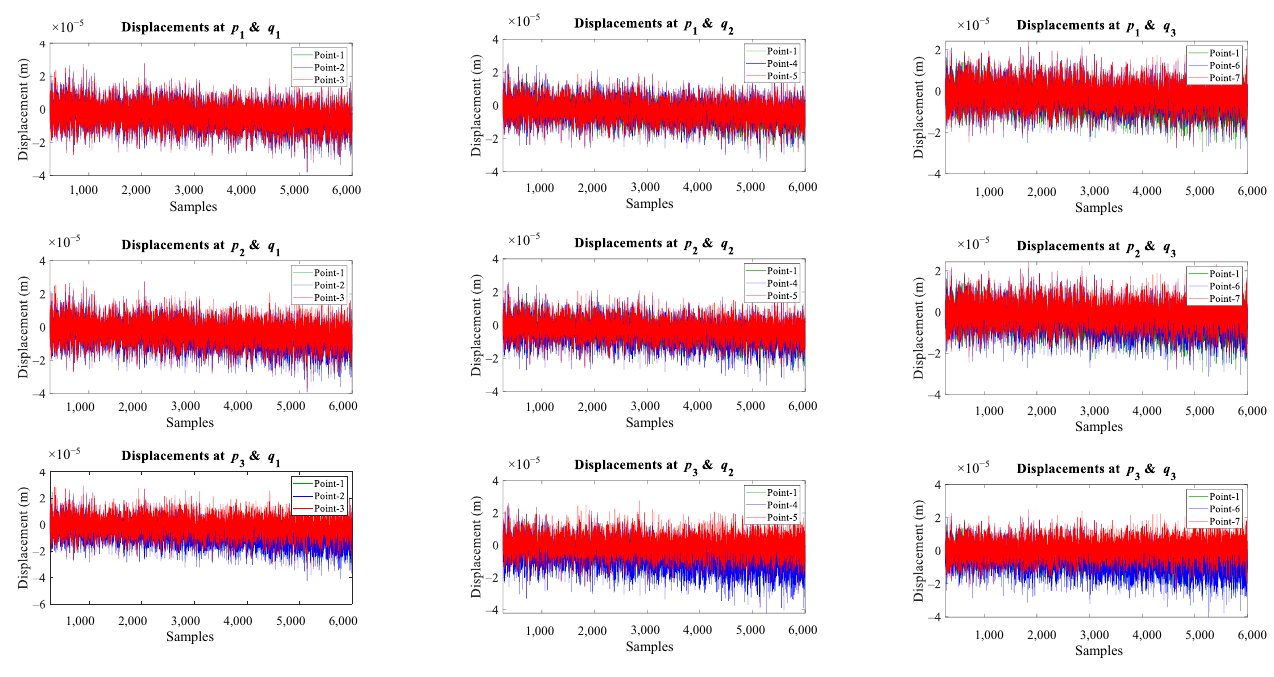
Figure 8. Sampling intervals vs. displacement responses recorded from different sensors of a fixed-fixed beam before and after crack location.